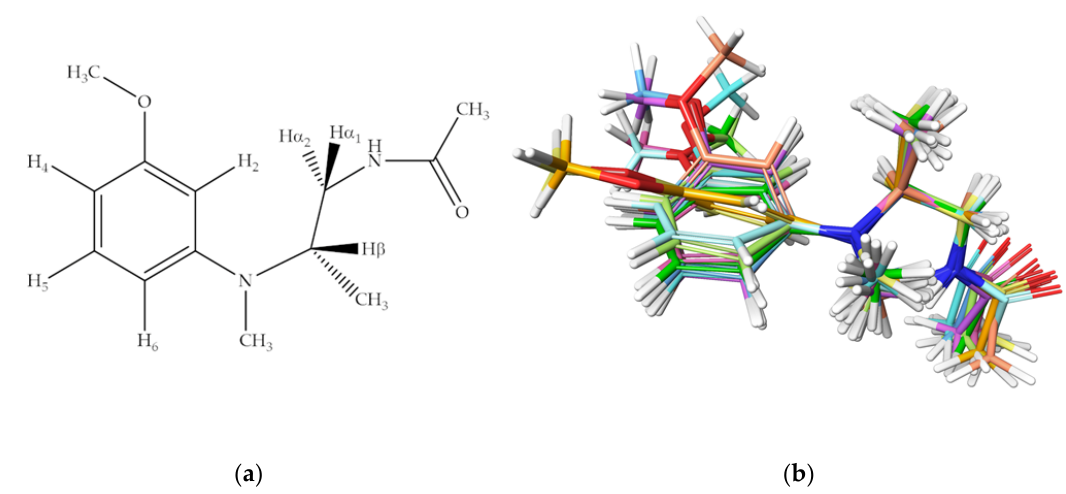
Figure 7. Structure of ( S )- 10 with proton labels ( a ) and ( b ) superposition of 10 frames from MD simulation of ( S )- 10 in chloroform taken from the minimum-energy cluster represented in Figure 6 (τ 1 −150° and τ 2 60°).